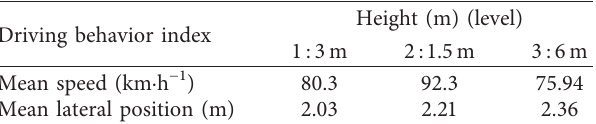
Table 5: Driving behavior index results under various levels of color factors.